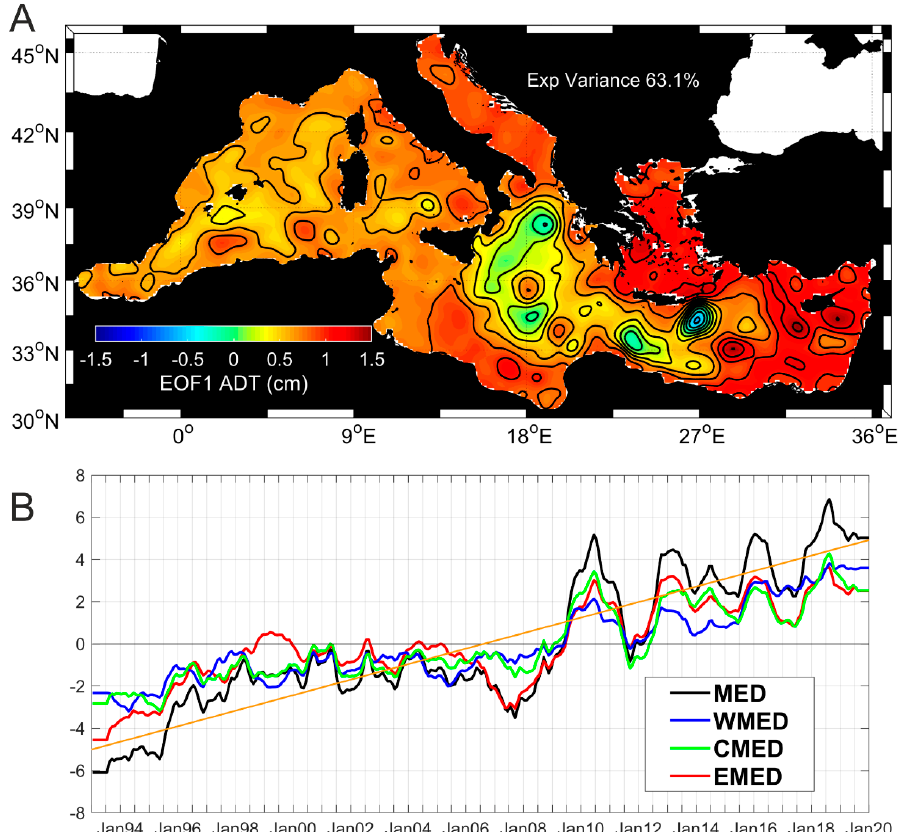
Figure 2. EOF1 ( A ) and PC1s ( B ) of the ADT. The PC1s ( B ) are estimated for the whole Mediterranean (MED, black line) and for the three main sub-basins separately (West Mediterranean—WMED, blue line; Central Mediterranean—CMED, green line; Eastern Mediterranean—EMED, red line). The long-term linear trend (orange line) is estimated on the PC1 of MED.